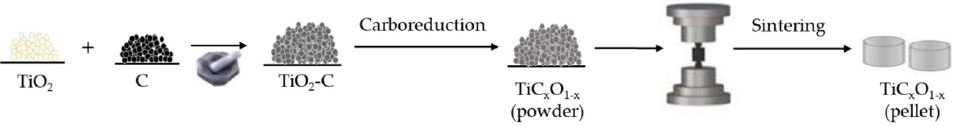
Figure 1. The diagram summarizes the process of synthesis and shaping of the titanium oxycarbide anode.